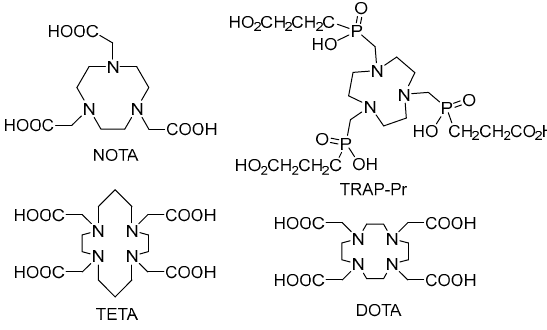
Figure 2. Chemical formulas of cyclic chelators.